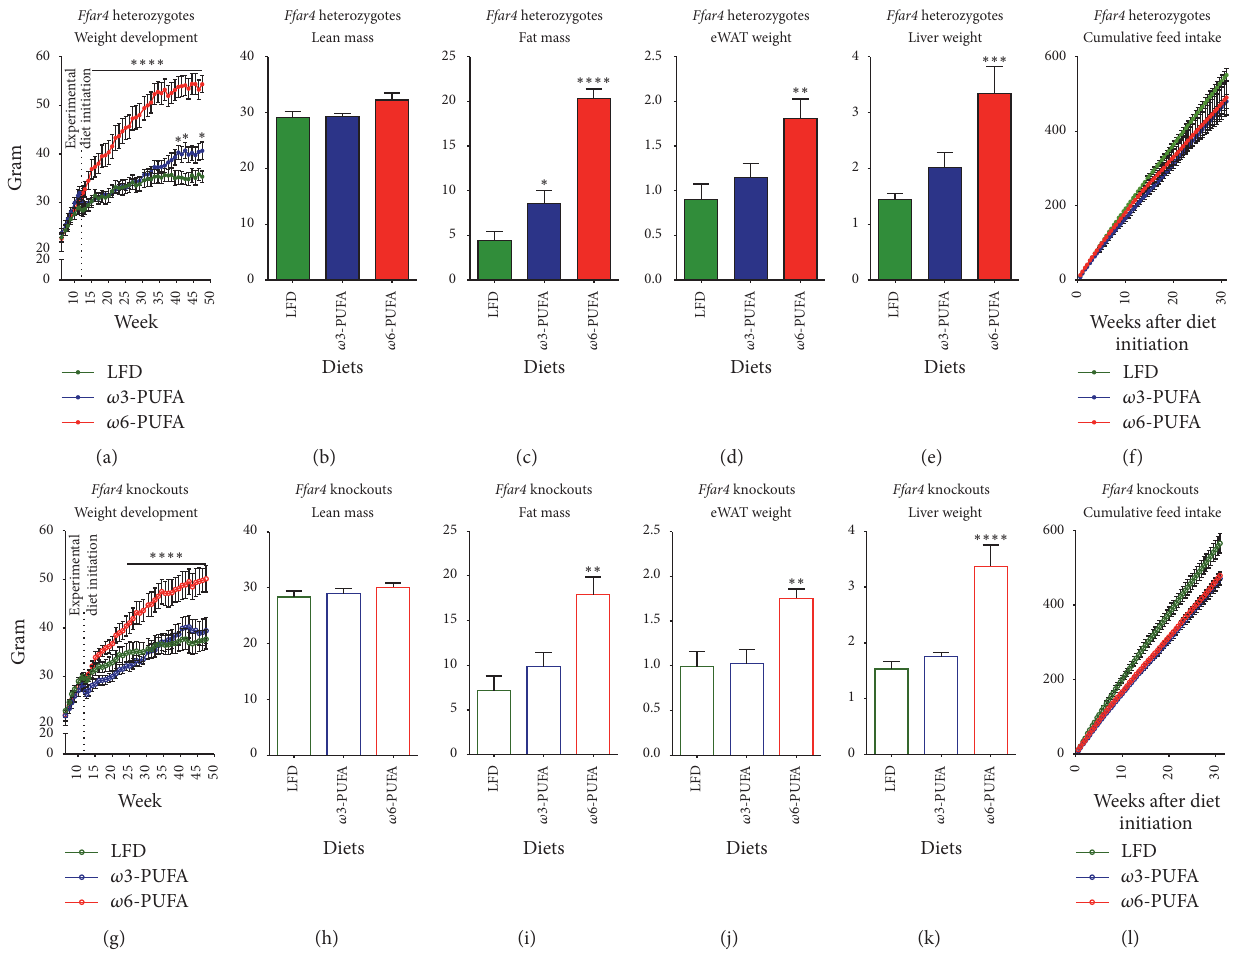
Figure 1: Ffar4 HET and KO mice are protected against obesity development on a high fat 𝜔 3-PUFA diet. Mice were scaled weekly from 6 weeks of age; experimental diets were initiated when mice were 11 weeks old. ((a)–(f)) Heterozygotes. ((g)–(l)) Knockouts. ((a) and (g)) Weight development, 𝑛 = 6 –8. ((b) and (h)) Lean mass from MR scans 32 weeks after diet initiation (43 weeks of age), 𝑛 = 6 –8. ((c) and (i)) Fat mass from MR scans 32 weeks after diet initiation, 𝑛 = 6 –8. ((d) and (j)) eWAT weights 36 weeks after diet initiation, 𝑛 = 6 –8. ((e) and (k)) Liver weights 36 weeks after diet initiation, 𝑛 = 6 –8. ((f) and (l)) Feed intake measured two times a week in single-housed mice till 32 weeks after diet initiation, 𝑛 = 5 –7. All data are presented as means ± SEM. Both HFDs are compared to the LFD. For (a), (f), (g), and (l) data were Ln-transformed and 2-way RM ANOVA with Bonferroni correction was performed. All data shown in bar graphs were Ln-transformed and subjected to 1-way ANOVA with Bonferroni correction. Only statistical significant differences are shown. ∗ 𝑝 < 0.05 , ∗∗ 𝑝 < 0.01 , ∗∗∗ 𝑝 < 0.001 , and ∗∗∗∗ 𝑝 < 0.0001